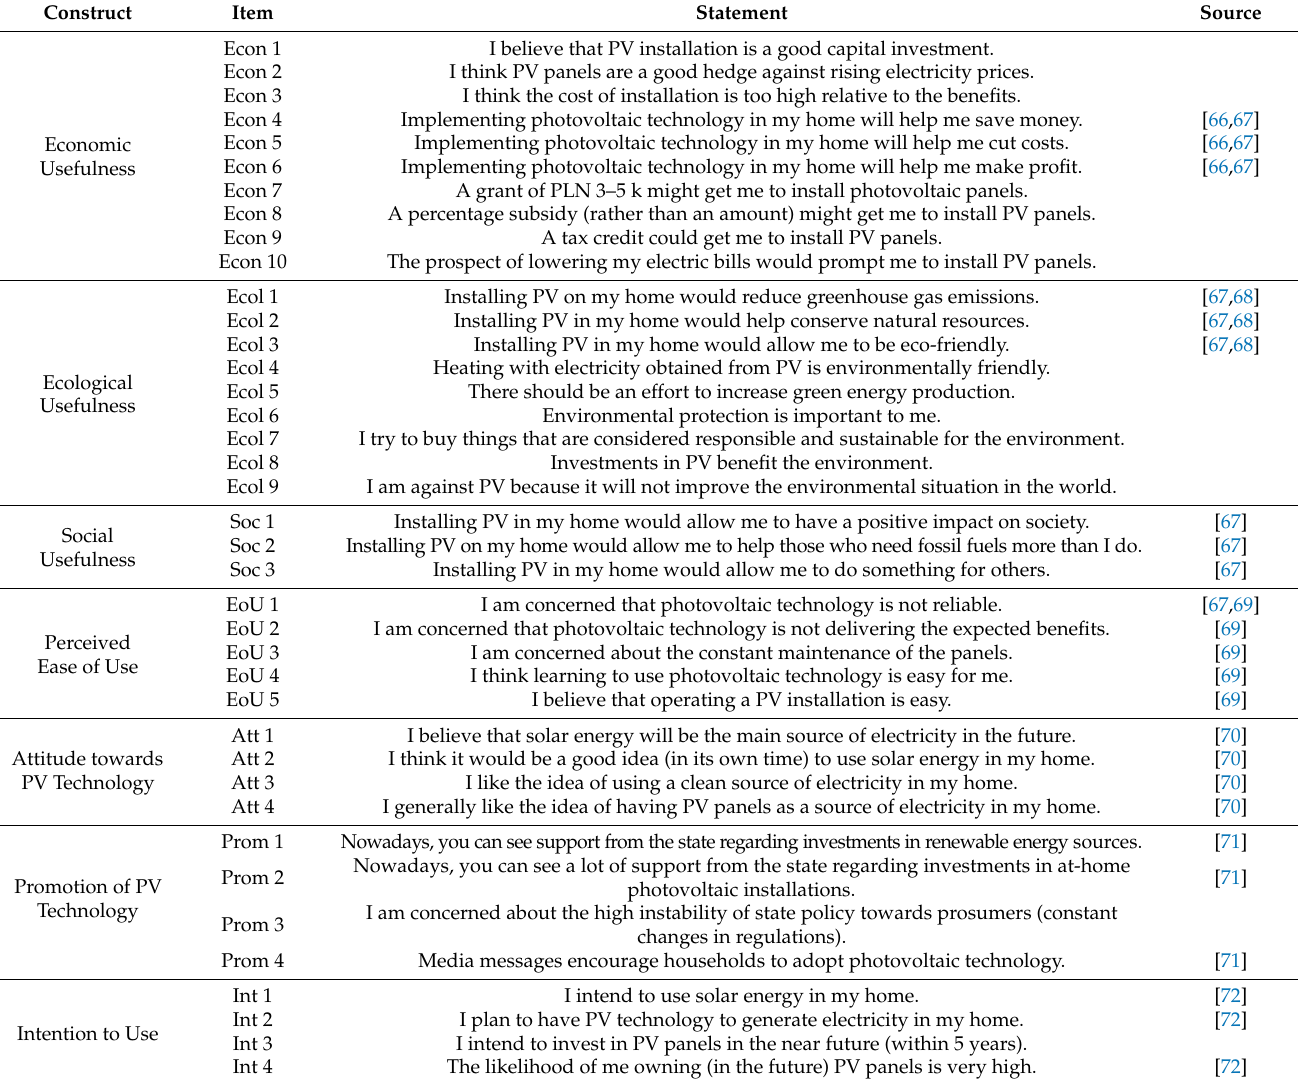
Table 1. Questionnaire used in the